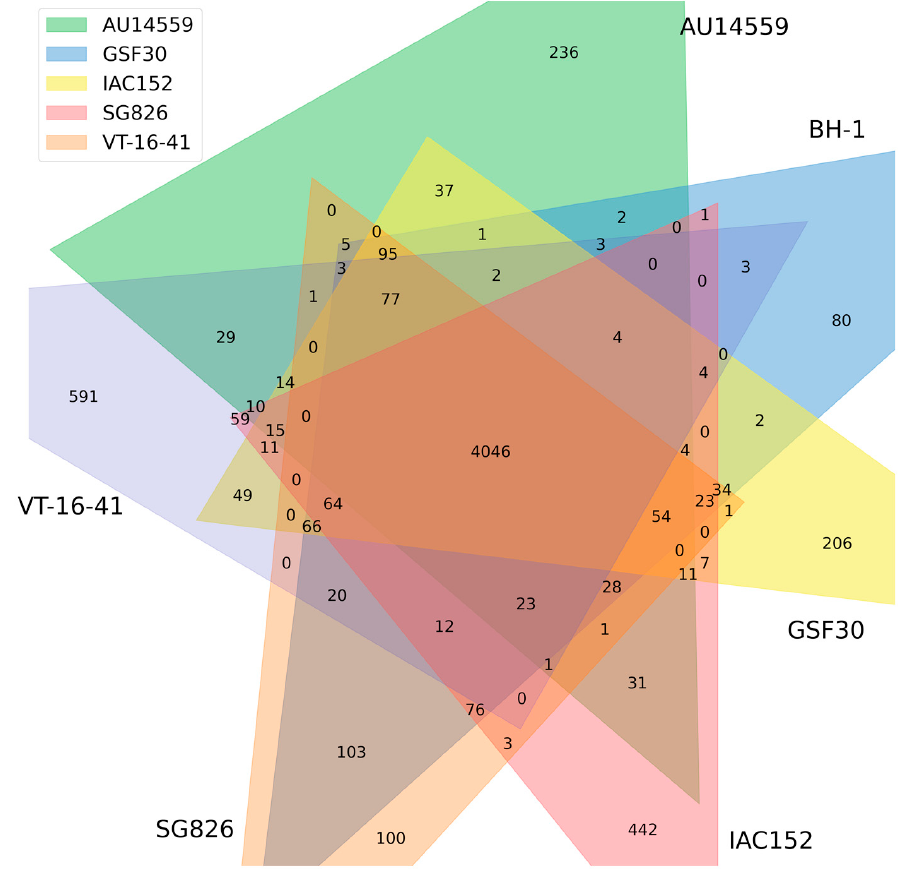
Figure 3. Analysis of the pangenome and core genome of H. frisingense . Venn diagram representing the homologous genes (identity > 50%) among genomes according to pan and core genome analysis performed by Panaroo. Each color in the graph represents a set of genes present in each genome. The numbers located in the non-overlapping regions between the polygons represent the total number of unique gene clusters in each strain. The numbers located in the overlapping regions between the polygons represent the total number of gene clusters identified by Panaroo that are shared among these strains. The central region of the graph represents the total cluster shared among all strains of H. frisingense ; this cluster represents the core genome of this species.